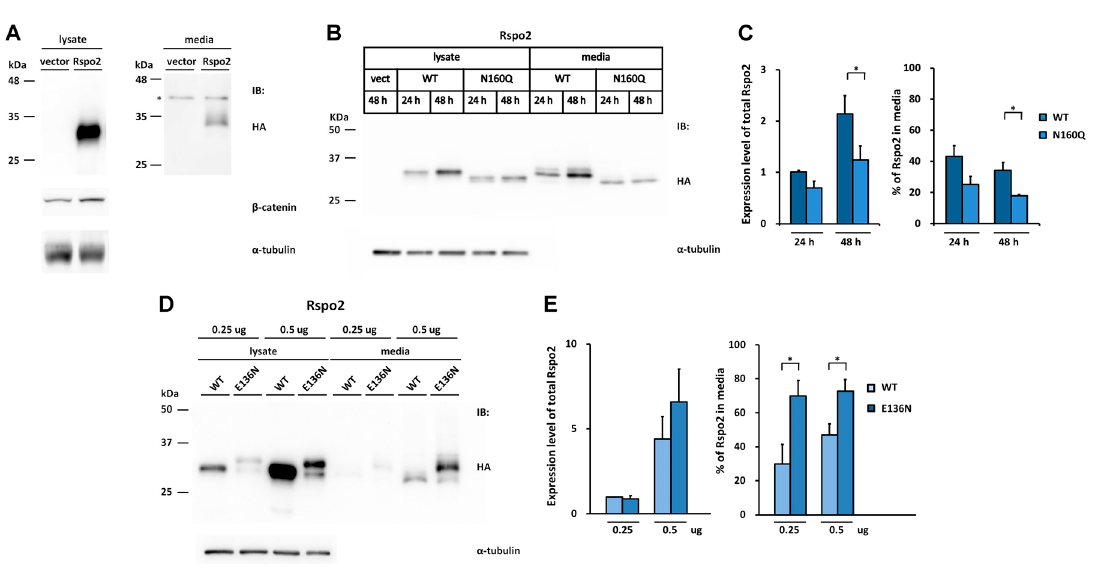
Figure 5. Cont. Figure 5.